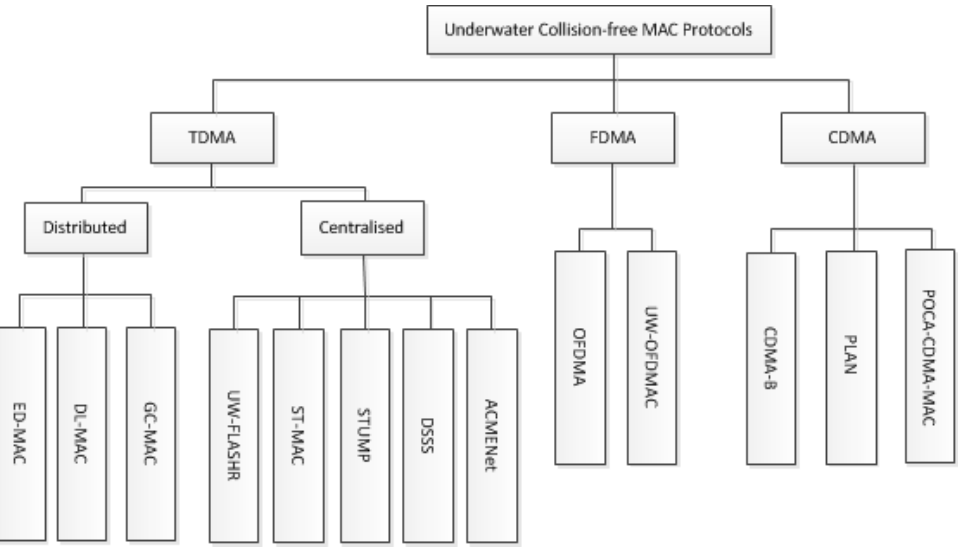
Figure 7. Classification of collision-free medium access control (MAC) protocols for